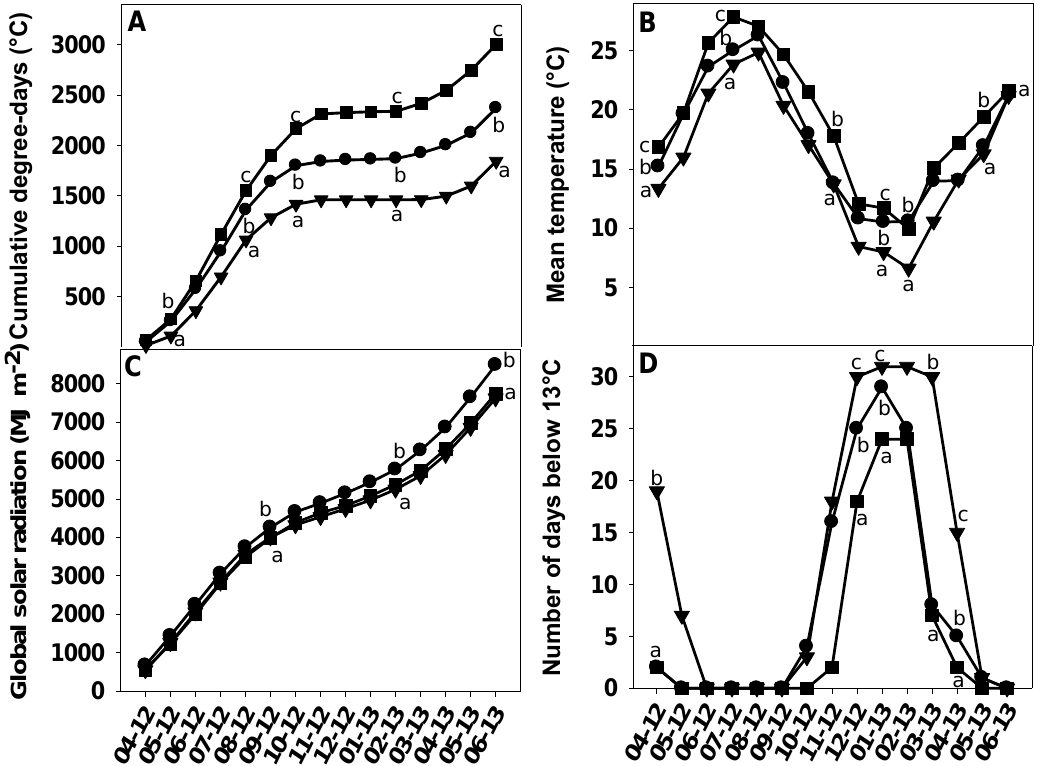
Figure 2. Climatic data recorded during the 2012/2013 season in Corsica ( ▼ ) , Spain (●) and Tunisia ( ■ ). A ) Monthly variation in cumulative degree-days (°C). B ) Mean temperature (°C). C ) Global solar radiation (MJ m −2 ). D ) Number of days with temperatures below 13 °C. The different letters indicate statistically significant differences ( p ≤ 0.05).